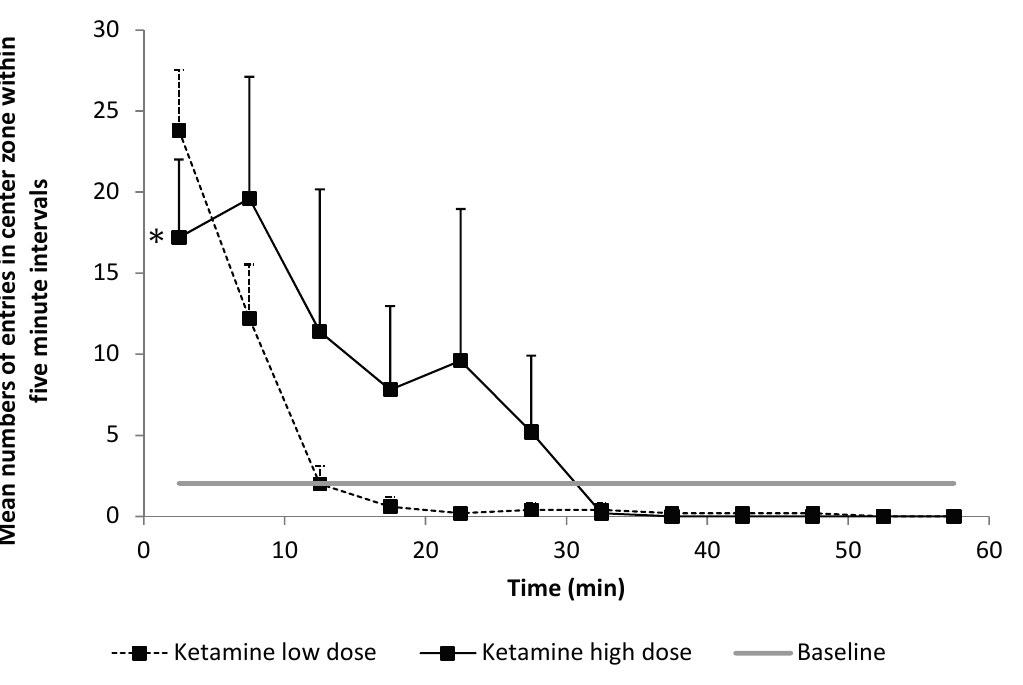
Figure 5. Number of entries into the central zone indicating the anxiety-related behavior of the animal, as evaluated within 5-min intervals. Compared to baseline, rats entered the central zone of the open field (OF) more frequently after ketamine anesthesia ( p < 0.021). This effect was shown to be significantly higher after 40 mg/kg ketamine vs. 20 mg/kg ketamine (* p =